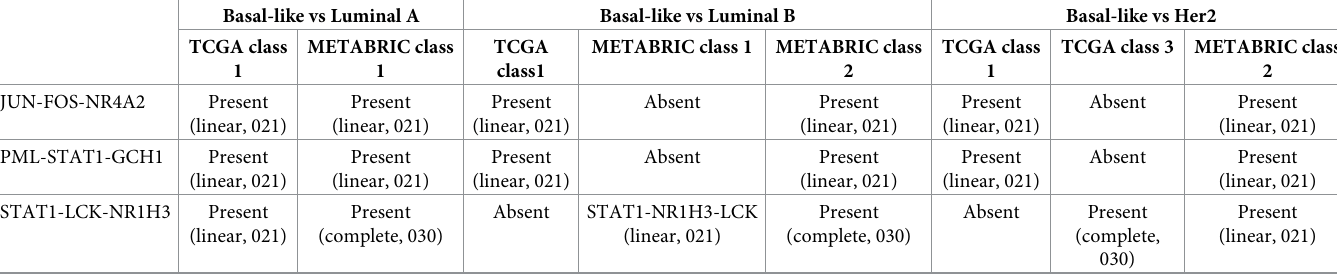
Table 3. Occurrence of the critical 3-node motifs enriched in Basal-specific networks. Motif type is described in the bracket. Basal-like vs Luminal